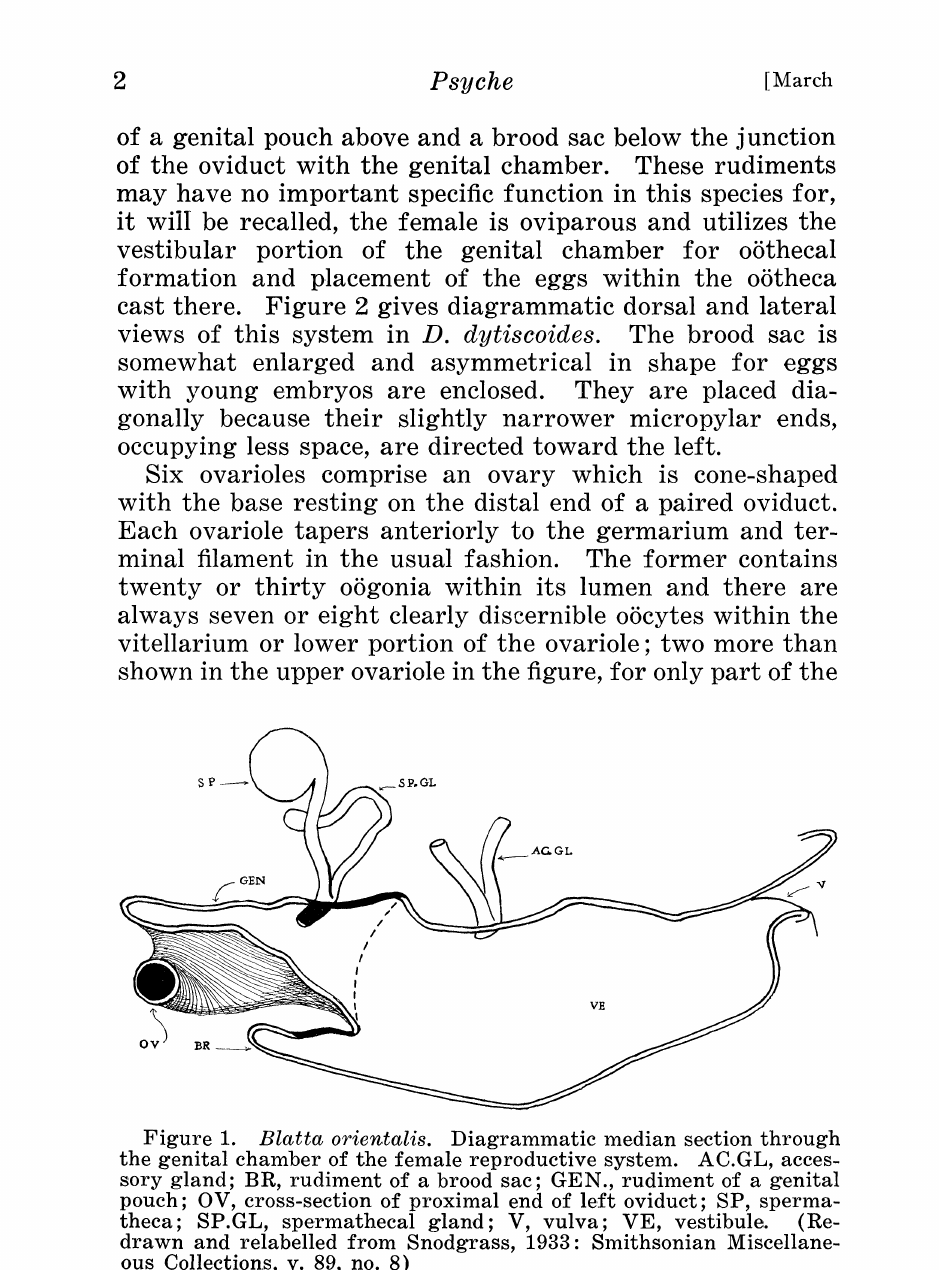
Figure 1. Blatta orientalis. Diagrammatic median section through the genital chamber of the female, reproductive system. AC.GL, acces- sory gland; BR, rudiment of a brood sac; GEN., rudiment of a genital pouch; OV, cross-section of proximal end of left oviduct; SP, sperma- theca; SP.GL, spermathecal gland; V, vulva; VE, vestibule. (Re- drawn and relabelled from Snodgrass, 1933: Smithsonian Miscellane- ous Collections, v. 89, no.